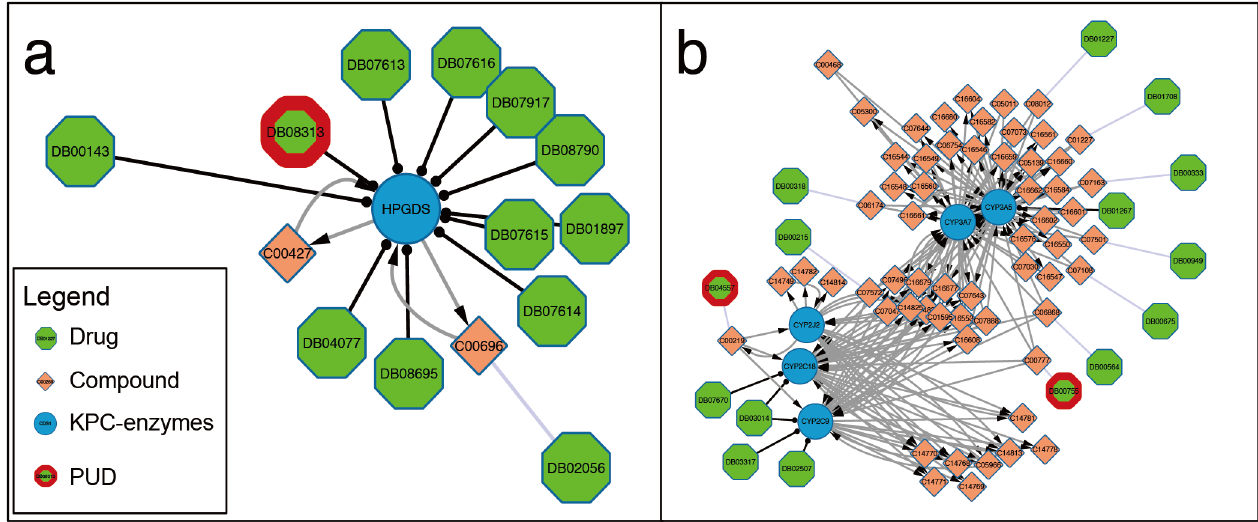
Fig 3. Network structure illustrating the relationships between the selected candidate drugs for treating pancreatic cancer and the relevant KPC enzymes. The examples of selected drugs are: A. nocodazole; B. tretinoin and